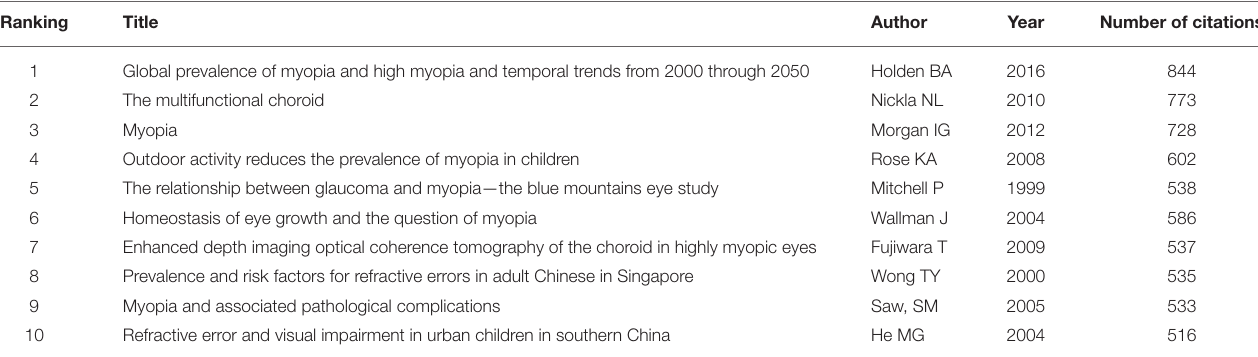
TABLE 5 | Top 10 cited papers in myopia citation